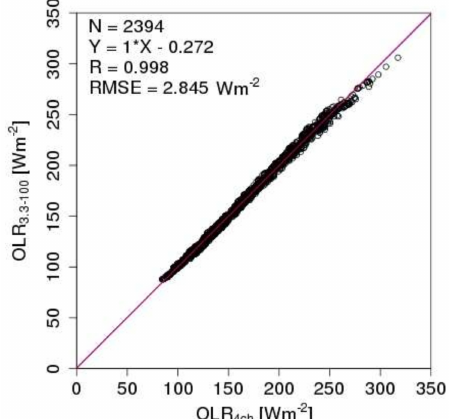
Figure 4. Scatter diagram of OLR 4ch and the results of the radiative transfer model simulation integrated by 3.3–100 µ m wavelength region (OLR 3.3–100 ). The 1:1 line is in red and the regression line is in